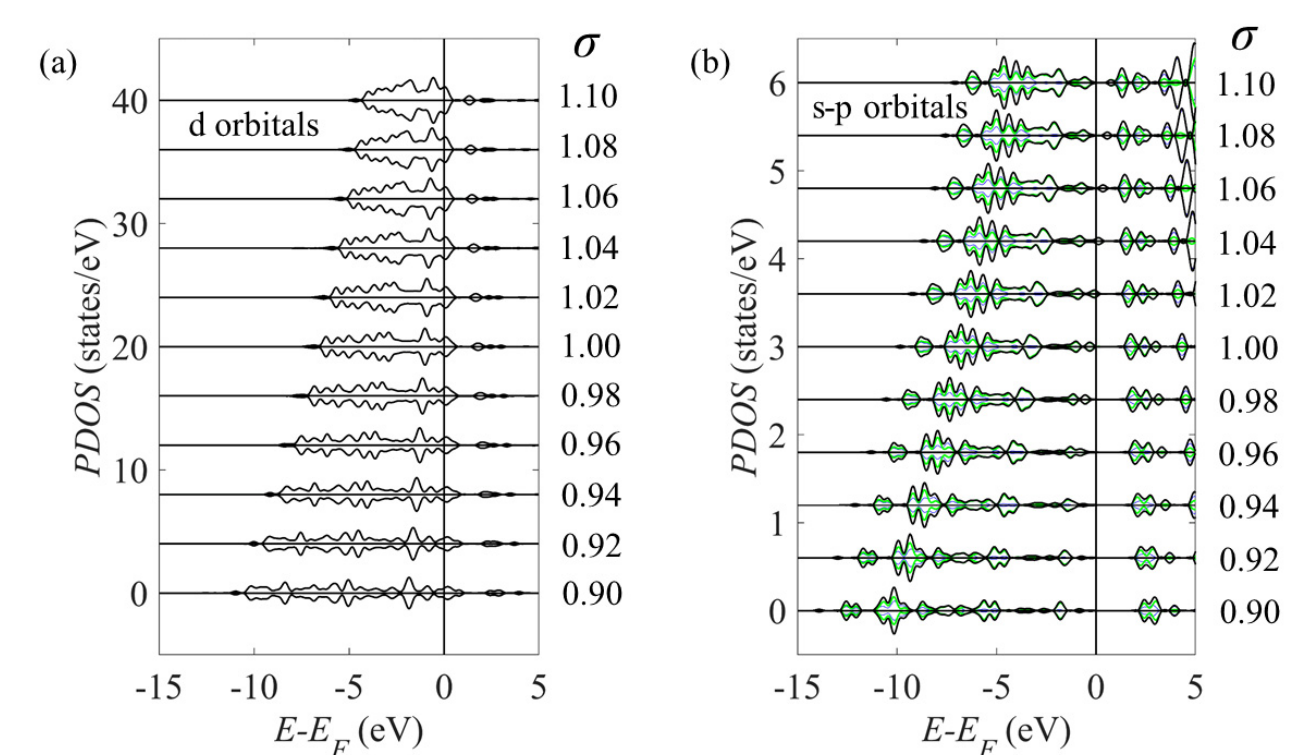
Figure 6. Projected density of states (PDOS) of the ( a ) d and ( b ) s-p orbitals for strained bulk Pt. The thin blue and green lines in ( b ) are the s and p PDOS, respectively, and the thick black line is the sum of the s and p PDOS. Each panel shows the spin up and down components as positive and negative curves, respectively. Subsequent curves are offset vertically for clarity and correspond to different amounts of strain σ .